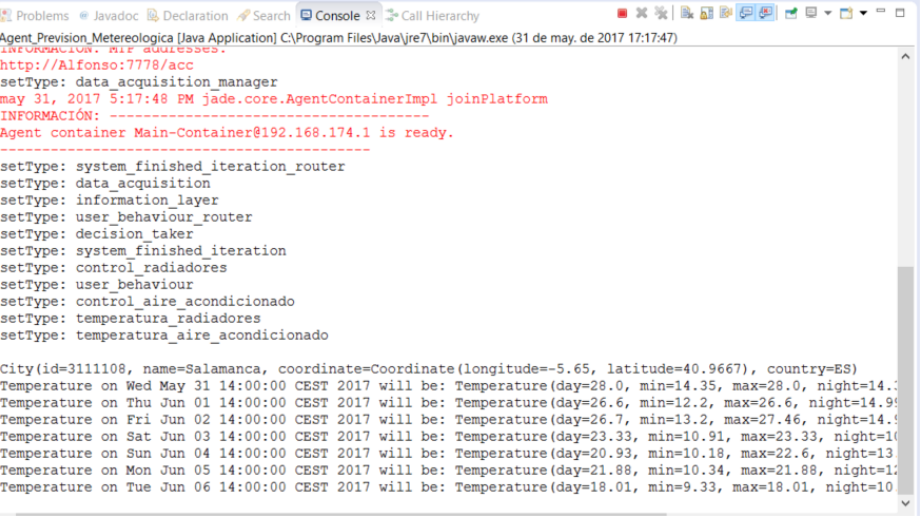
Figure 4. Weather forecast agent.